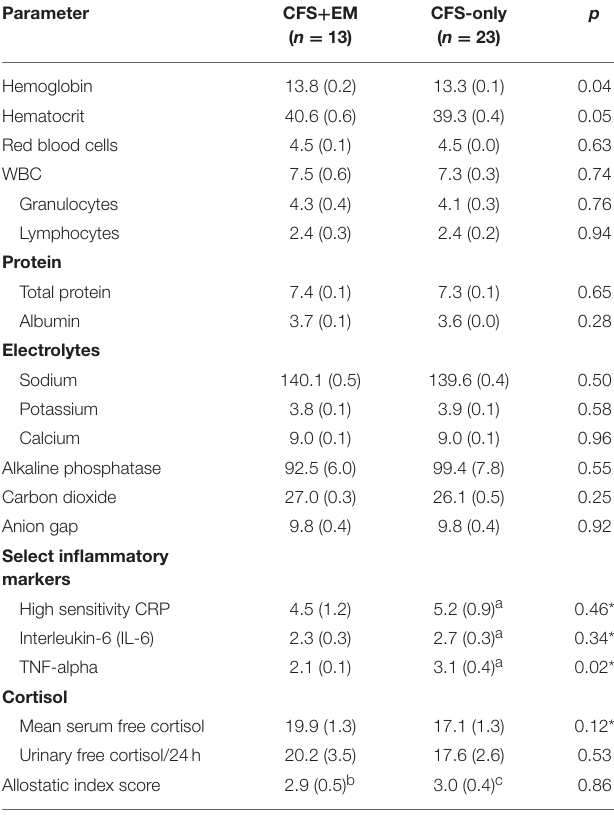
TABLE 4 | Comparisons of mean values for selected laboratory parameters and allostatic load index in women with CFS, by subgroup—with and without endometriosis comorbidity.